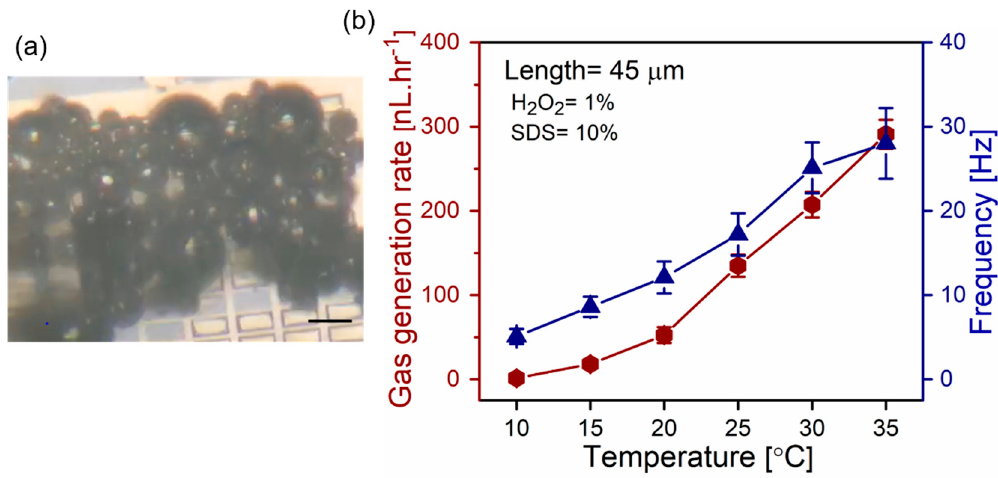
Figure 5. ( a ) Optical microscopy image of oxygen bubbles evolving from 45 µm catalytic tubes immersed in 1% v / v hydrogen peroxide fuel and 10% v / v SDS surfactant; ( b ) oxygen generation from catalytic microtube (left y-axis) and frequency of the microbubbles (right y-axis) at a constant SDS concentration (10% v / v) and H 2 O 2 (1% v / v) versus temperature. Insets are optical micrographs of individual Ti / Cr / Pd tubes generating oxygen bubbles.